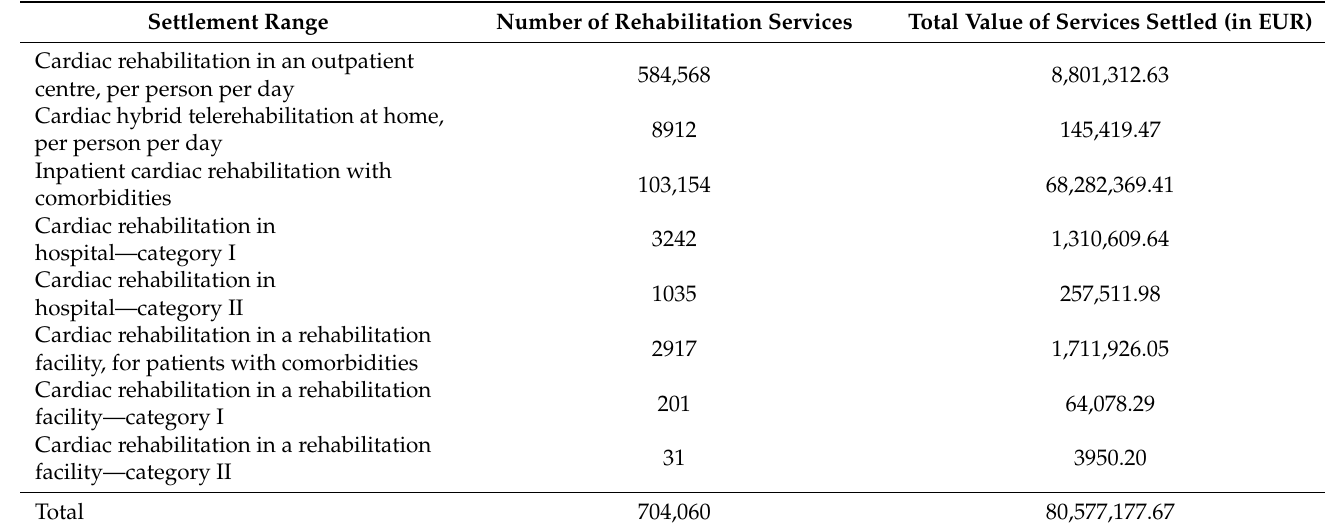
Table 6. Expenditure (in EUR) on the rehabilitation of patients not covered by